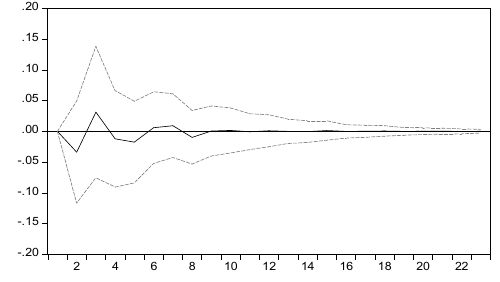
Figure 3. Response of NETEX to CONFI Figure 4 shows the impulse response of LOAN to CONFI . It can be seen from Fig. 5 that after a shock to CONFI in this period, the LOAN will have a cyclical positive reaction in the early stage, and then reach a peak and then weaken to zero, and then periodically change with the decrease of the amplitude, gradually converge to zero and the effect disappears. After the trade war, the Chinese government adopted an expansionary fiscal policy to stabilize economic growth and a number of RRR cuts to release liquidity. Therefore, the amount of credit will increase in the short term. However, after the increase to the peak, the spontaneous adjustment mechanism came into effect, and the credit growth rate showed a slowing trend. This is then repeated until the effect of the impact is digested, and the corresponding pulse corresponding map converges to the zero axis.